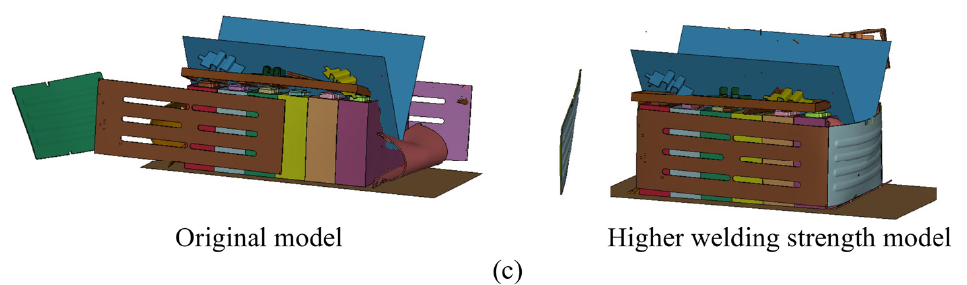
Figure 9. The FE model simulated module damage modes with original and increased welding strength: ( a ) Case 1; ( b ) Case 2; and ( c ) Case 3.